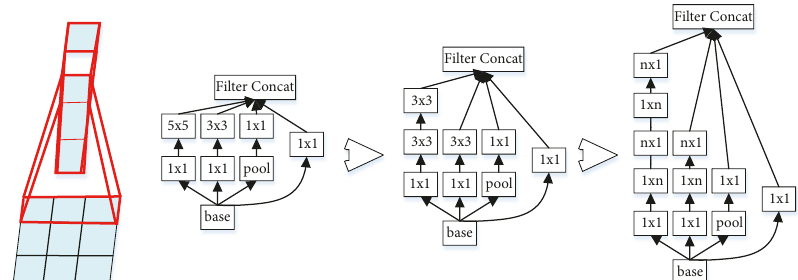
Figure 4: Mini-network replacing the 3 × 3 convolutions. The lower layer of this network consists of a 3 × 1 convolution with 3 output units.